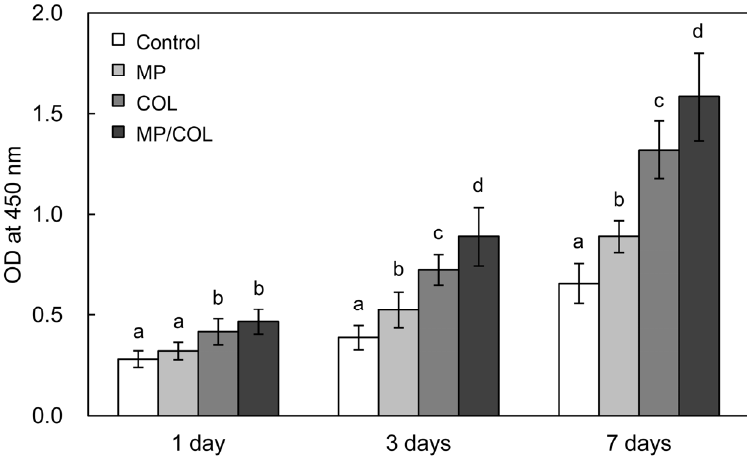
Figure 6. Proliferation of MG63 cells on the four experimental